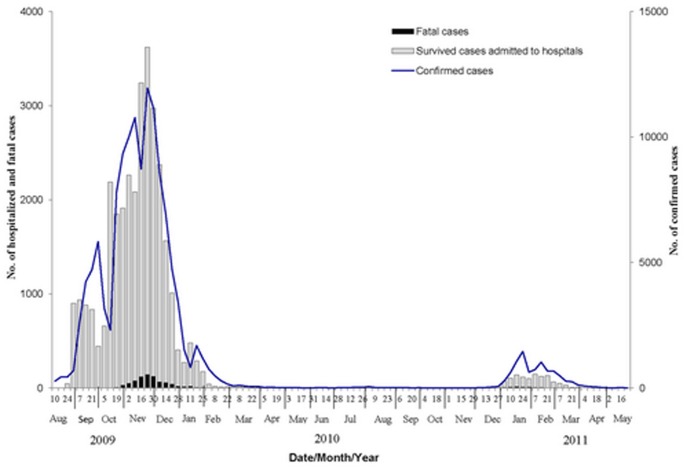
Flow diagram of enrollment of hospitalized cases with confirmed Influenza A(H1N1)pdm09 infection from November 2010 to May 2011.